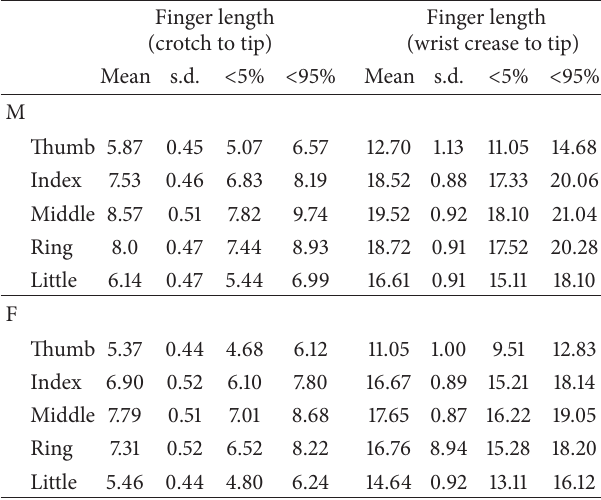
Table 1: Mean finger lengths and palm dimensions of USAF male